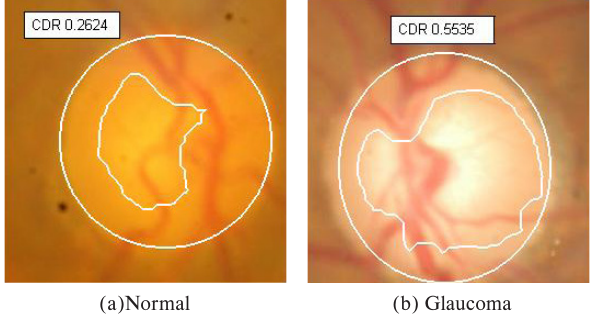
Fig. 2. CDR computations with elliptical optic disc and actual segmented contour for optic cup (SWFCM